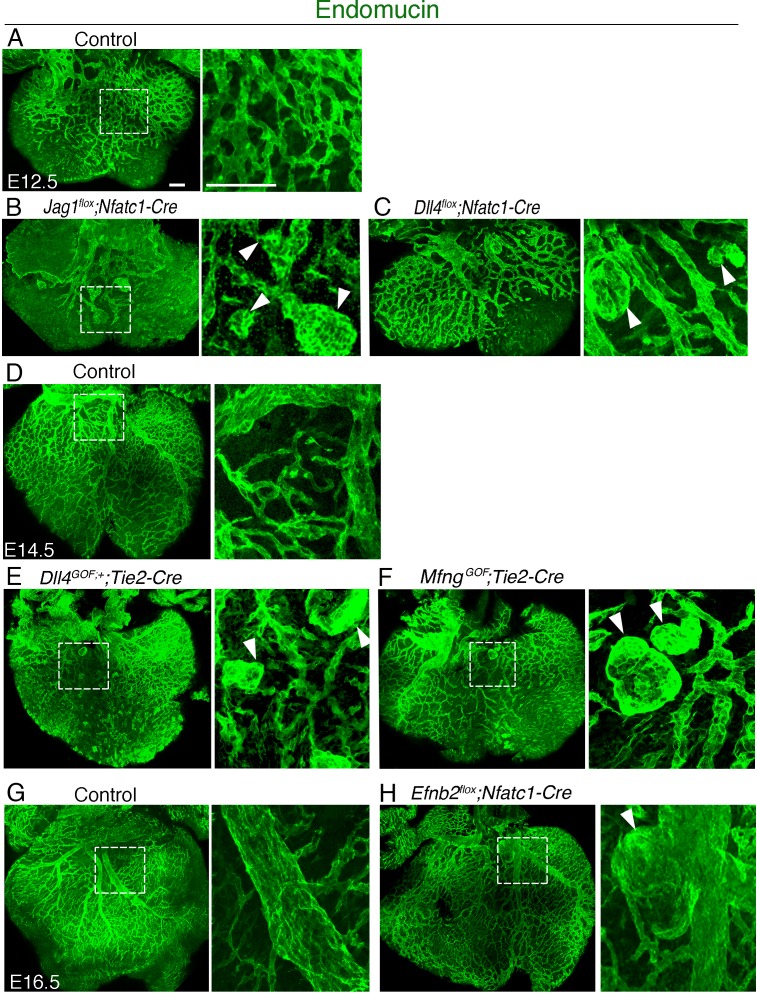
Coronary vessels of Notch pathway and Notch effector mutants display vascular malformations.Dorsal views of whole-mount immunostaining for Emcn (green). (A) E12.5 control heart, (B) E12.5 Jag1flox;Nfatc1-Cre heart, (C) E12.5 Dll4flox;Nfatc1-Cre heart, (D) E14.5 control heart, (E) E14.5 Dll4GOF;Tie2-Cre heart, (F) E14.5 MfngGOF;Tie2-Cre heart, (G) E16.5 control heart, (H) E16.5 Efnb2flox;Nfatc1-Cre heart. Scale bars, 100 μm.